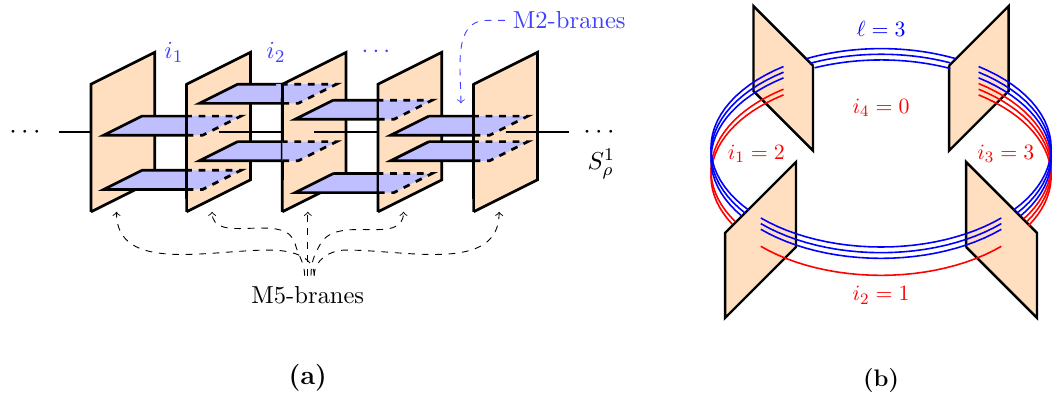
Figure 1 . (a) Con(cid:12)guration of M5-branes (drawn in orange) with ( i 1 ; : : : ; i N ) M2-branes (drawn in blue) stretched between them. Here the direction normal to the M5-branes is compacti(cid:12)ed on the circle S 1 . (b) Schematic representation of the con(cid:12)guration of N = 4 with ( i 1 ; i 2 ; i 3 ; i 4 ) = (2 ; 1 ; 3 ; 0) (cid:26) and ‘ = 3. The blue lines represent the ’common’ number of 3 M2-branes stretched between each pair of M5-branes, while the red lines represent ’additional’ M2-branes leading to the con(cid:12)guration (2 ; 1 ; 3 ; 0). To obtain H (2 ; 1 ; 3 ; 0 ;r ) in (2.6) a summation over similar con(cid:12)gurations with all possible ( s 1 ;s 2 ) ‘ 2 N is